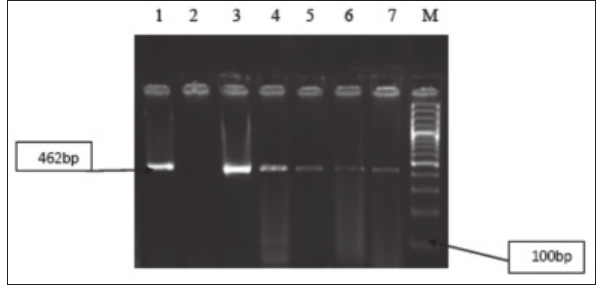
Agarose gel showing polymerase chain reaction amplified product at (462 bp) for ceu genes in Campylobacter isolates. Lane 1: Positive control; Lane 2: Negative control; Lane 3-7: Positive samples; M: Molecular marker (100 bp,